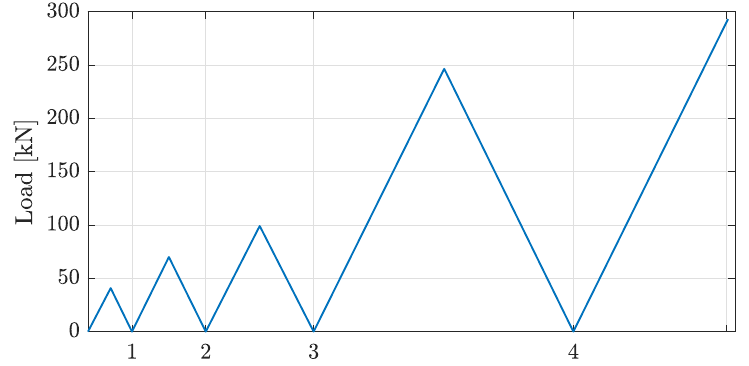
Figure 3. Loading protocol for the